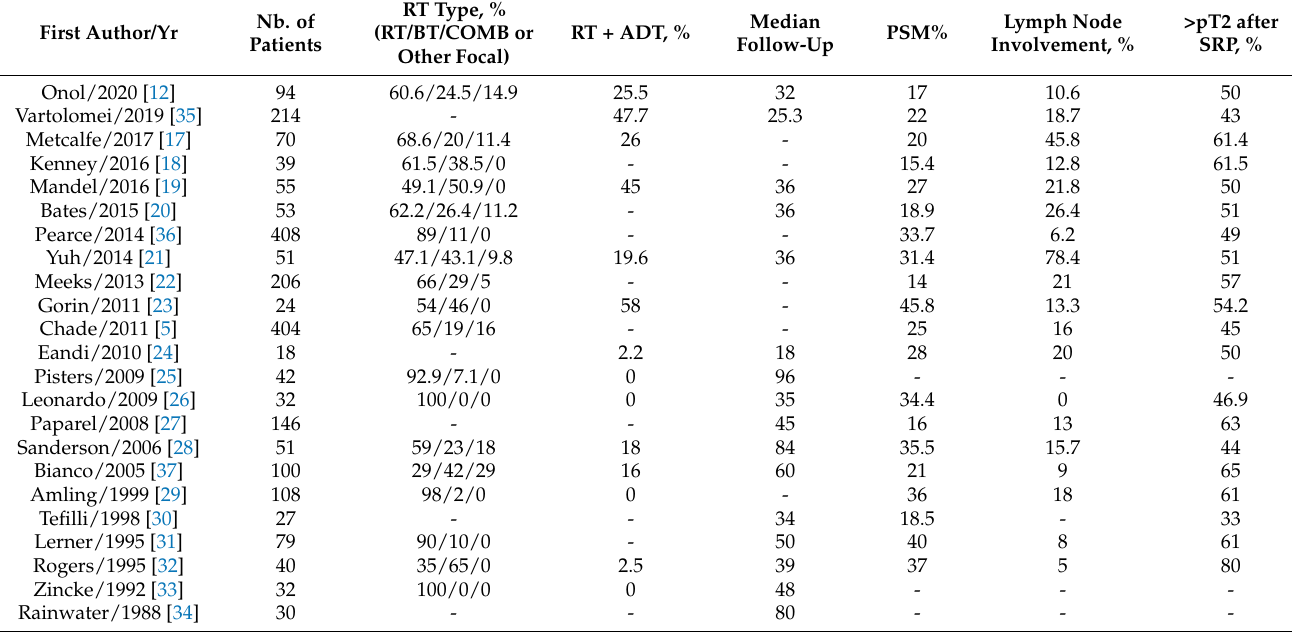
Table 1. Pathologic outcomes after salvage radical